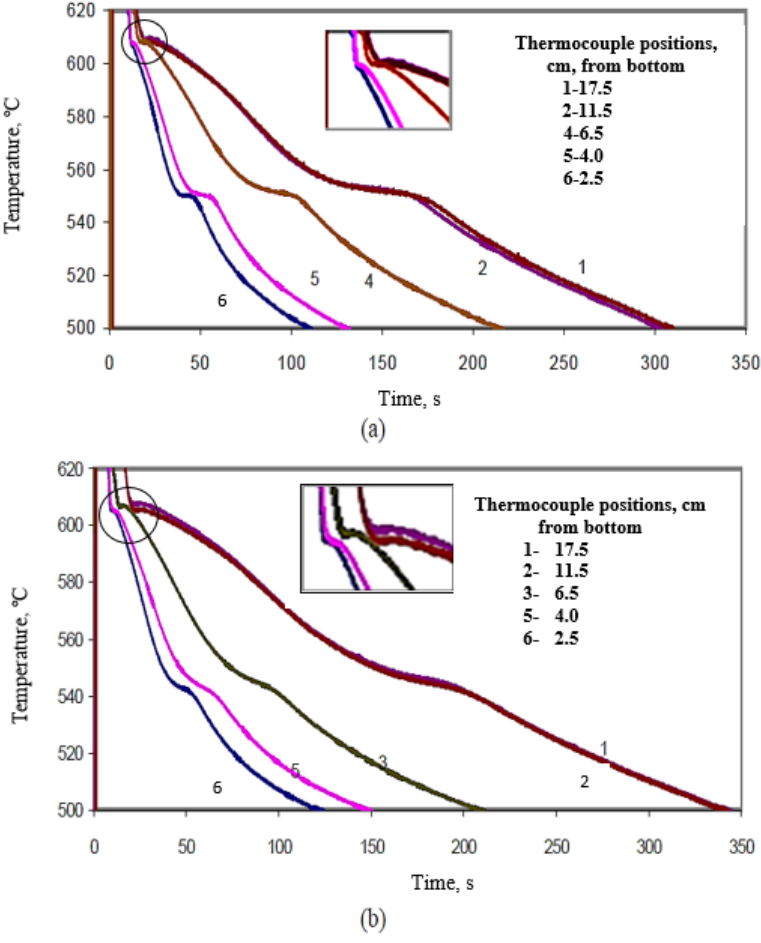
Figure 12. Solidification curves obtained for ( a ) B alloy, ( b ) C alloy, large mold (angle 15°).